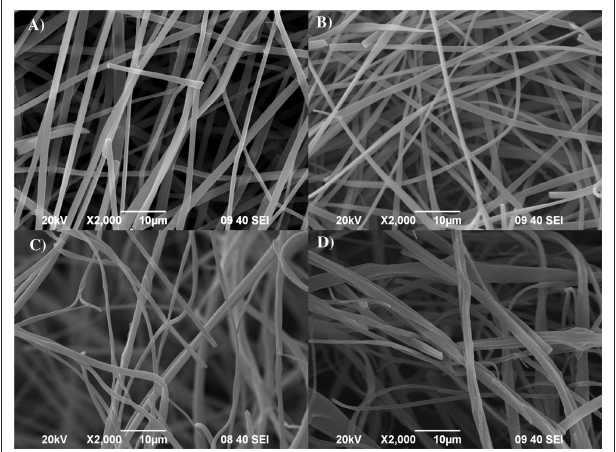
FIGURE 7 | SEM micrographs of (A,B) CFs with 1 and 5% of Pt, respectively; and (C,D) PCFs with 1 and 5% of Pt, respectively.